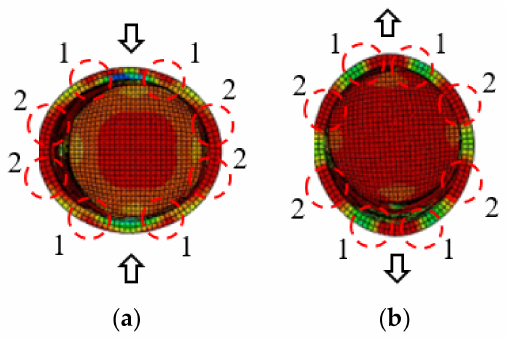
Figure 20. Plastic hinges formed in the circular tube (location 1 and 2): ( a ) under compression; ( b ) under